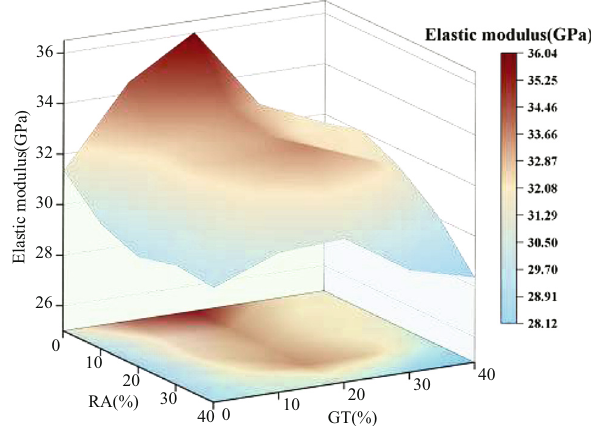
Figure 11: Elastic modulus of GTRAC.